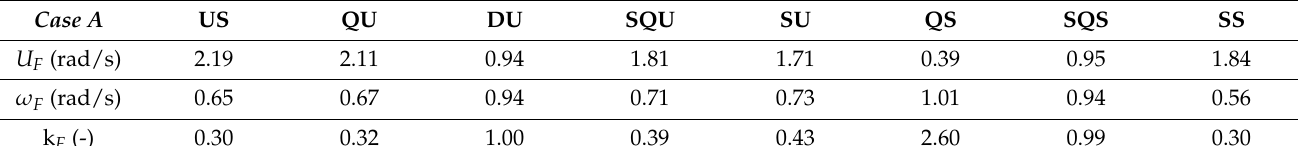
Table 3. Flutter analysis results for Case A using different aerodynamic models.